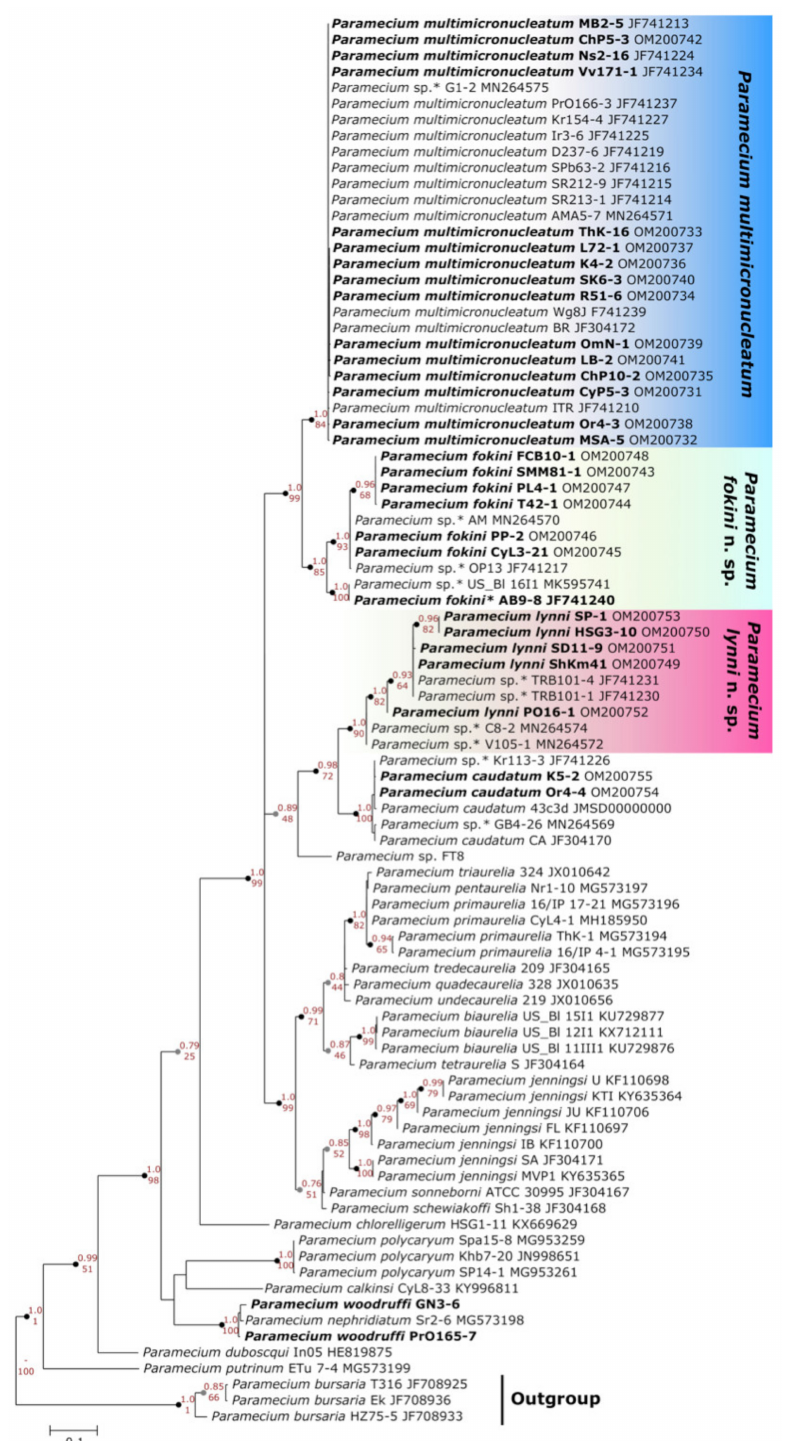
Figure 3. Phylogenetic position of three groups of Paramecium multimicronucleatum -like strains on the ITS region tree. Numbers associated with the nodes represent posterior probability from Bayesian inference (BI) and the bootstrap value from maximum likelihood (ML) analyses. Strains marked in bold were analyzed in this study. Asterisks (*) indicate the misidentified or non-identified at the species level strains in NCBI (see Table